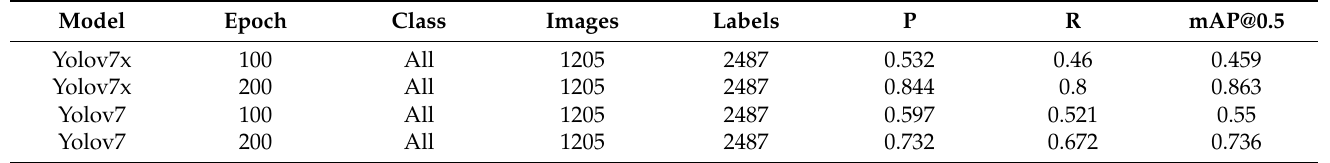
Table 2. Testing performance of Yolov7 and Yolov7x with Oxford Hand